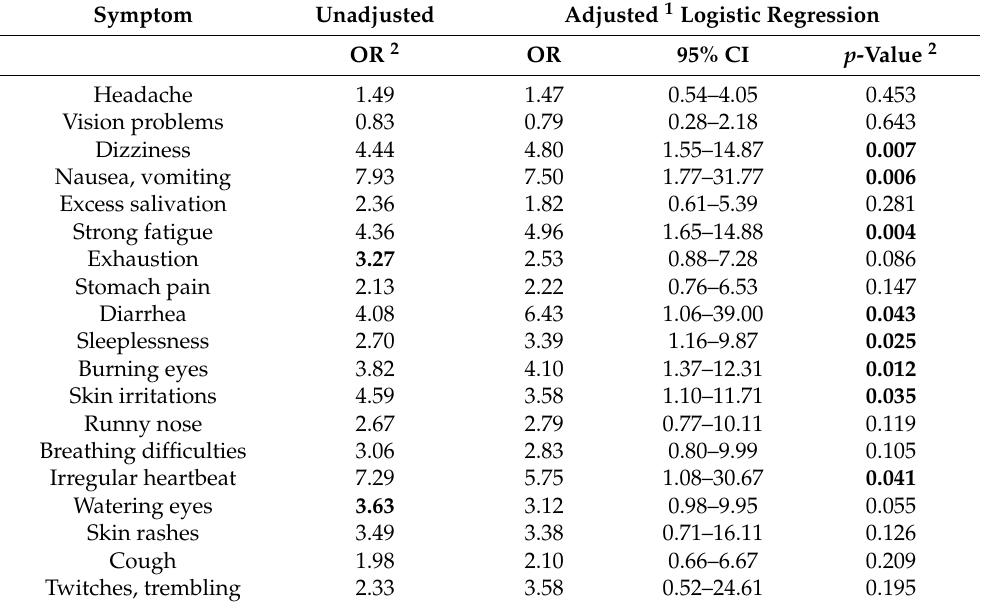
Table 5. Difference in reported symptom rates by